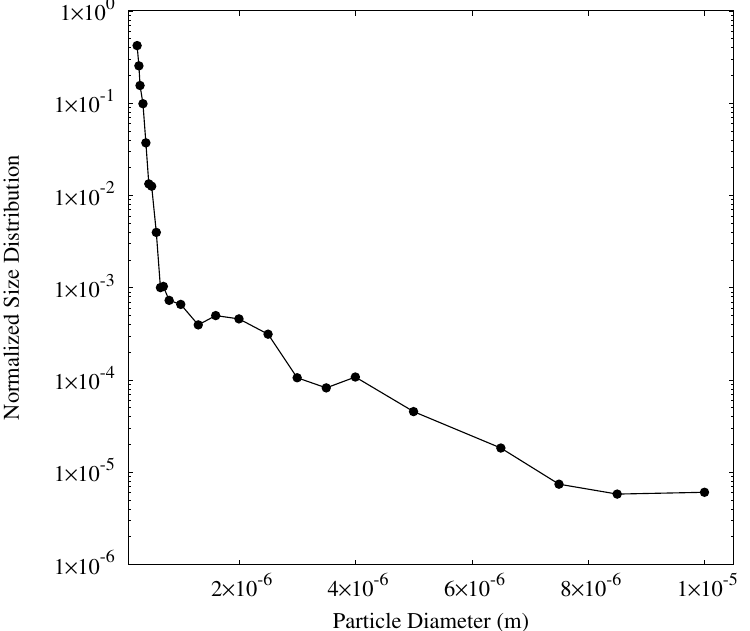
Figure 10. Particle size distribution injected in the application example. The size distribution was obtained from experiments with aerosolized manure in a wind tunnel, as described in